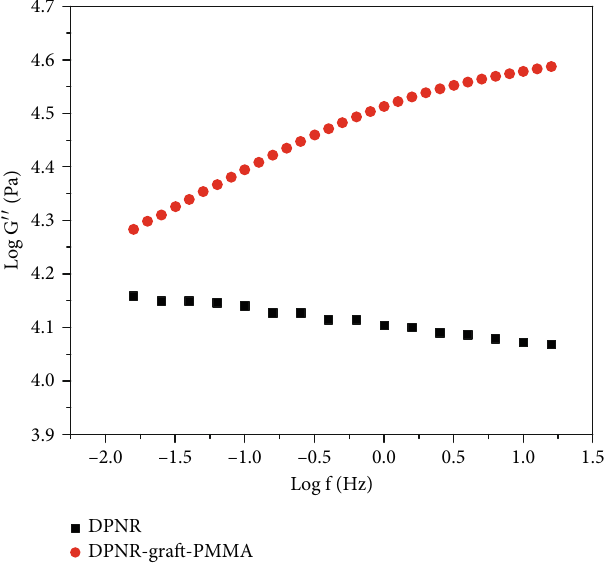
Figure 9: Loss modulus (G ″ ) in the plateau region vs frequency at 298K for DPNR and DPNR-graft-PMMA 15wt.%.